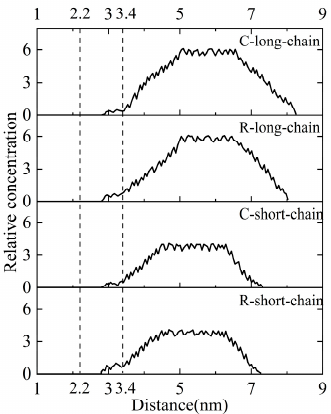
Figure 3. Concentration profile of PC atoms in conventional injection molding (CIM) and rapid heat cycle molding (RHCM) at the end of the filling stage. The distance between 2.2 and 3.4 nm is the depth of mold cavity. C and R in graphs indicate CIM and RHCM,